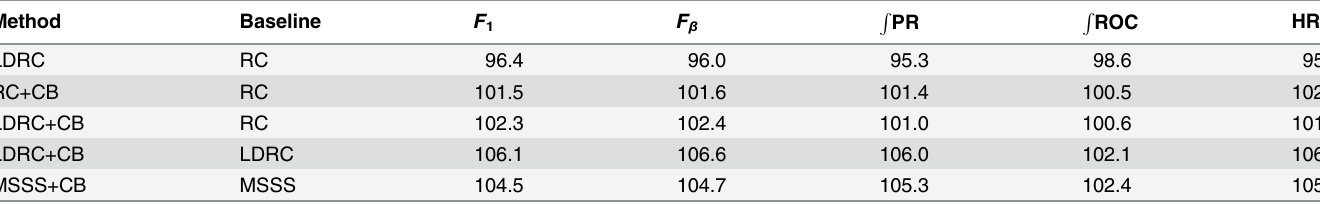
Table 3. Relative performance (in %) of our adapted algorithms with respect to their baseline.